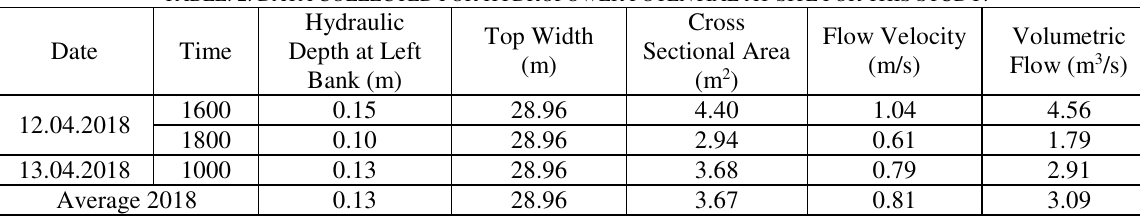
FIG. 4. LBOD CANAL DROP NEAR GOTH AHORI, JHUDDO TABLE. 2. DATA COLLECTED FOR HYDROPOWER POTENTIAL AT SITE FOR THIS